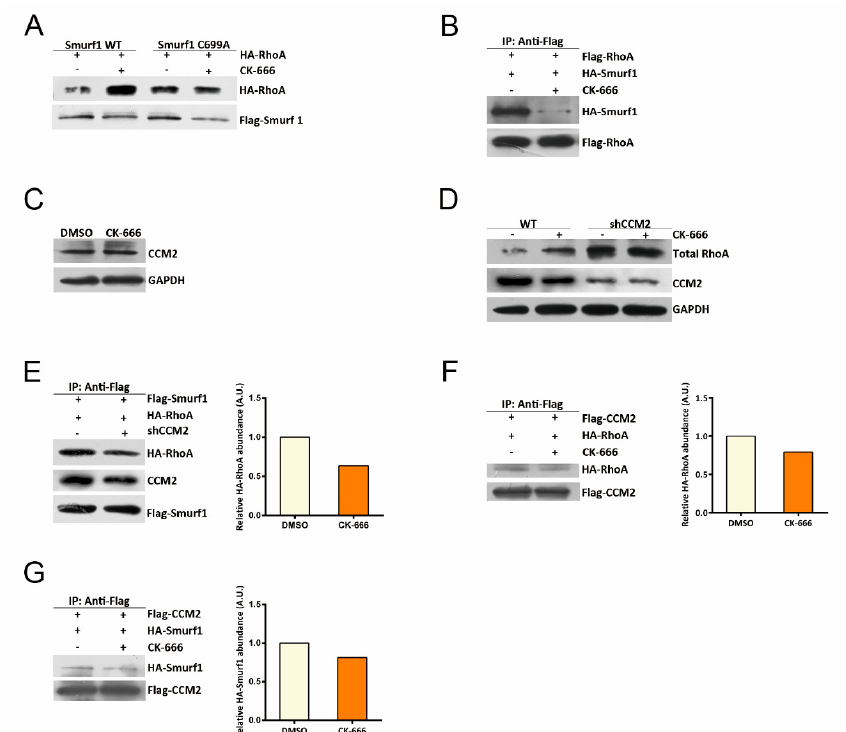
Figure 4. CCM2 and smurf1 are involved in increased RhoA level under Arp2/3 perturbation. ( A